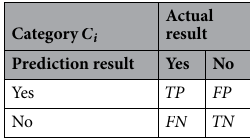
Table 3. Confusion matrix in this study. TP true positives, FP false positives, FN false negatives, TN true negatives.